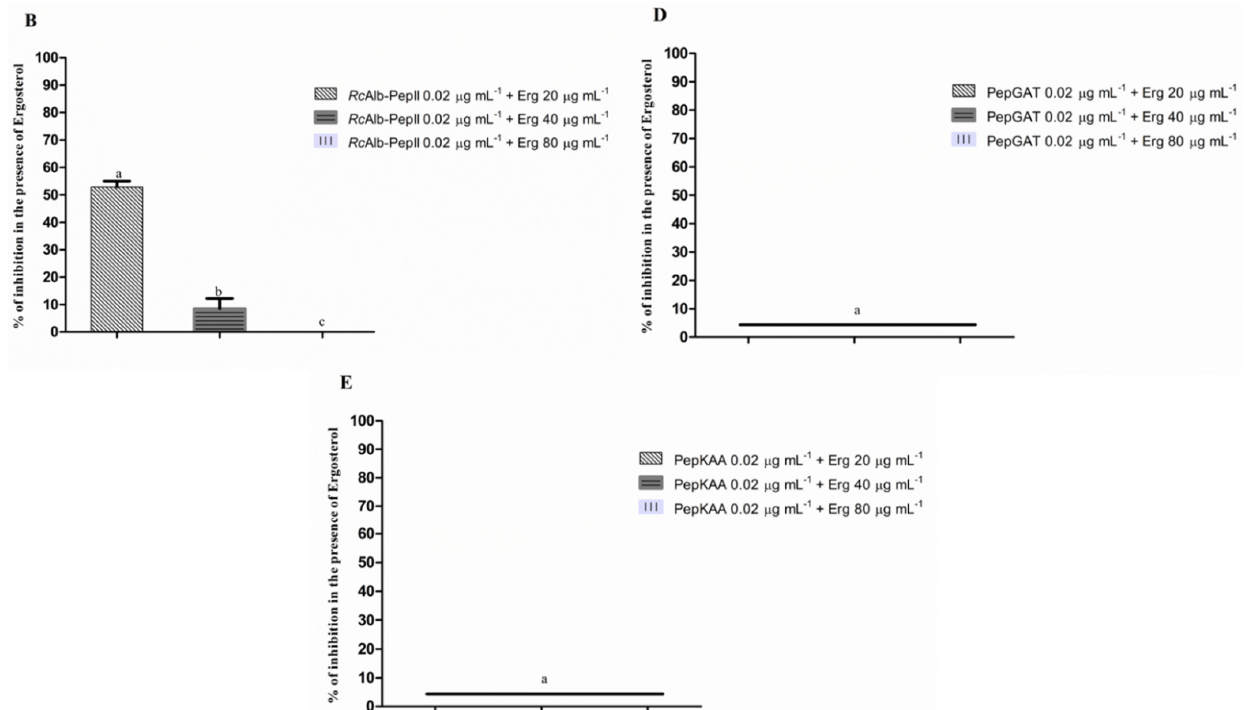
Figure 1. The interaction of ergosterol and its role in the antifungal activity of synthetic peptides. ( A ) Mo -CBP 3 -PepII, ( B ) Rc Alb-PepII, ( C ) Rc Alb-PepIII, ( D ) PepGAT, and ( E ) PepKAA DMSO-NaCl was used as a negative control. Data are presented as mean ± standard deviation (SD). Using the Tukey test, different letters represent the statistical difference ( p < 0.05). The experiment was repeated three times.